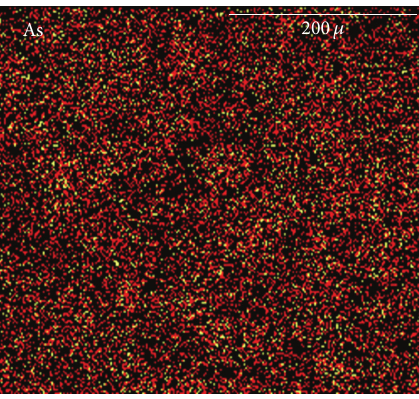
Figure 1: X-ray image of As in cement paste.